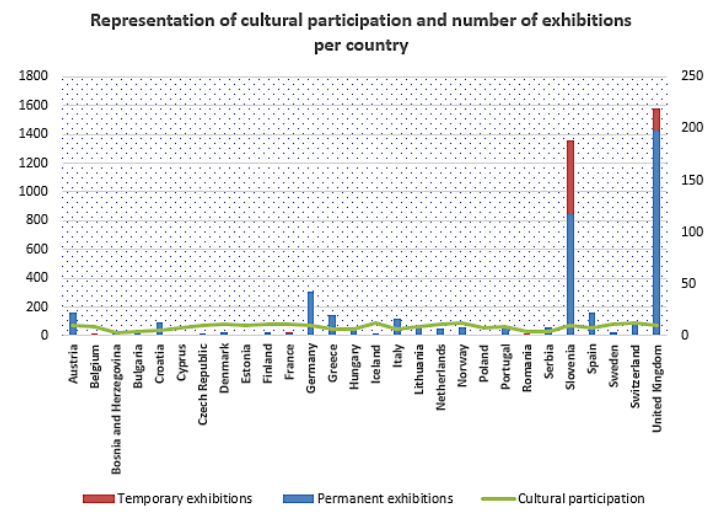
Figure 2. Representation of cultural participation and number of exhibitions per country (source: created by